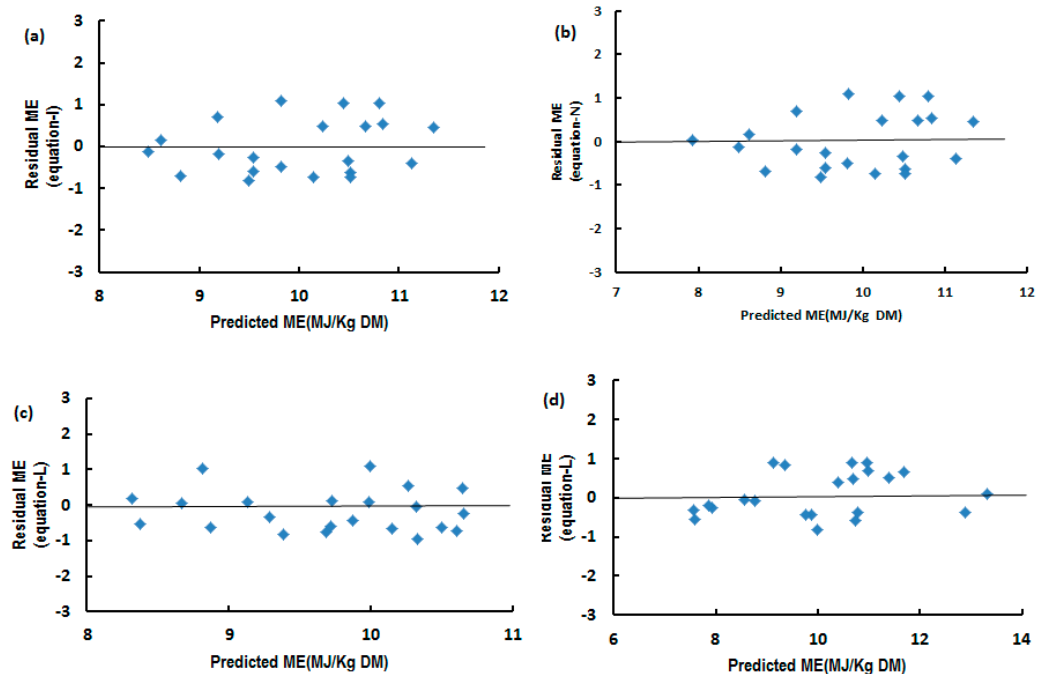
Figure 1. The relationship between residual ME concentration (predicted–actual) and predicted ME concentration from equations of I ( a ), N ( b ), L ( c ) and L ( d ) using one-thirds of the present data.